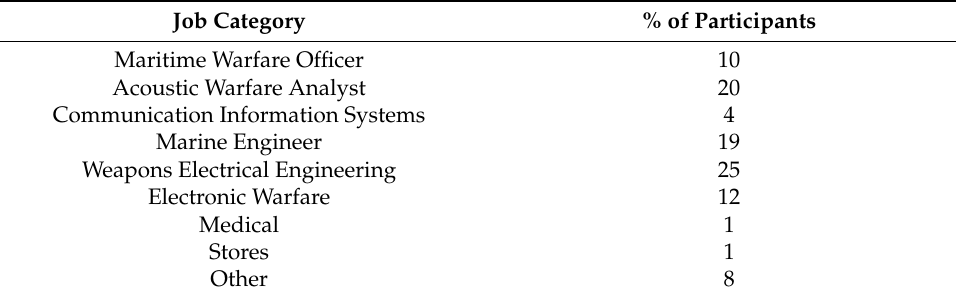
Table 1. Distribution of participant job